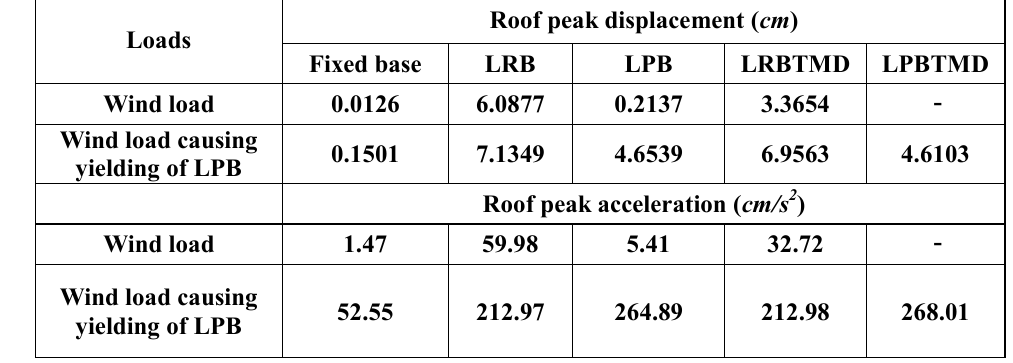
Table 7 Peak displacement and peak acceleration of roof under wind